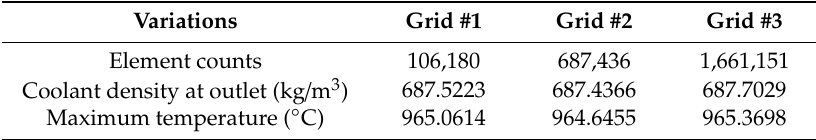
Table 7. Thermal-hydraulics results comparison of the WCCB with different grids.